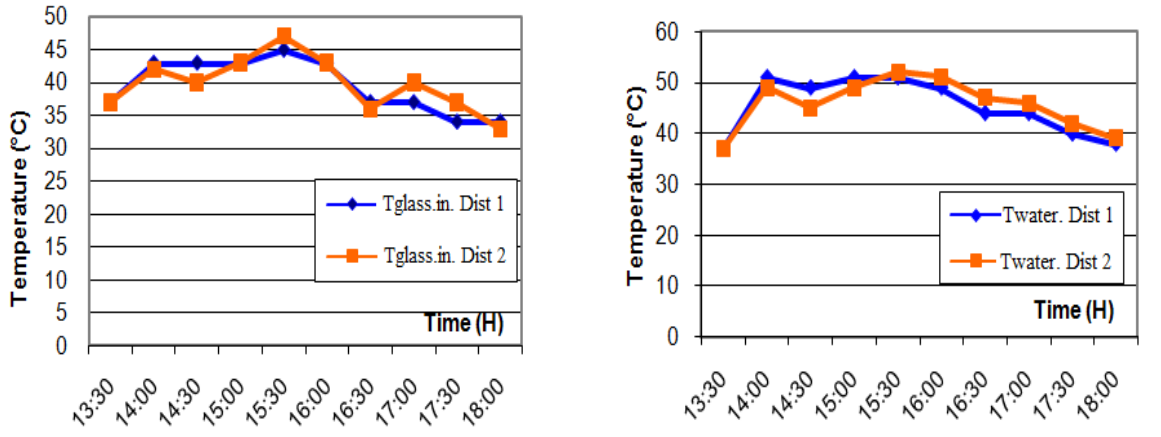
Figure 5a. Evolution of the glazing temperature Figure 5b. Evolution of the water